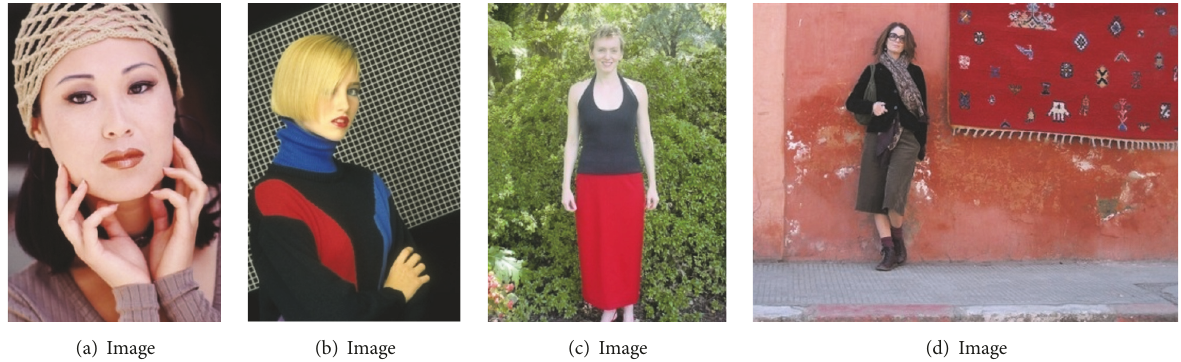
Figure 5: S -measure (DSR and MC): (a) 0.464, 0.344; (b) 0.510, 0.481; (c) 0.789, 0.654; (d) 0.844, 0.730.